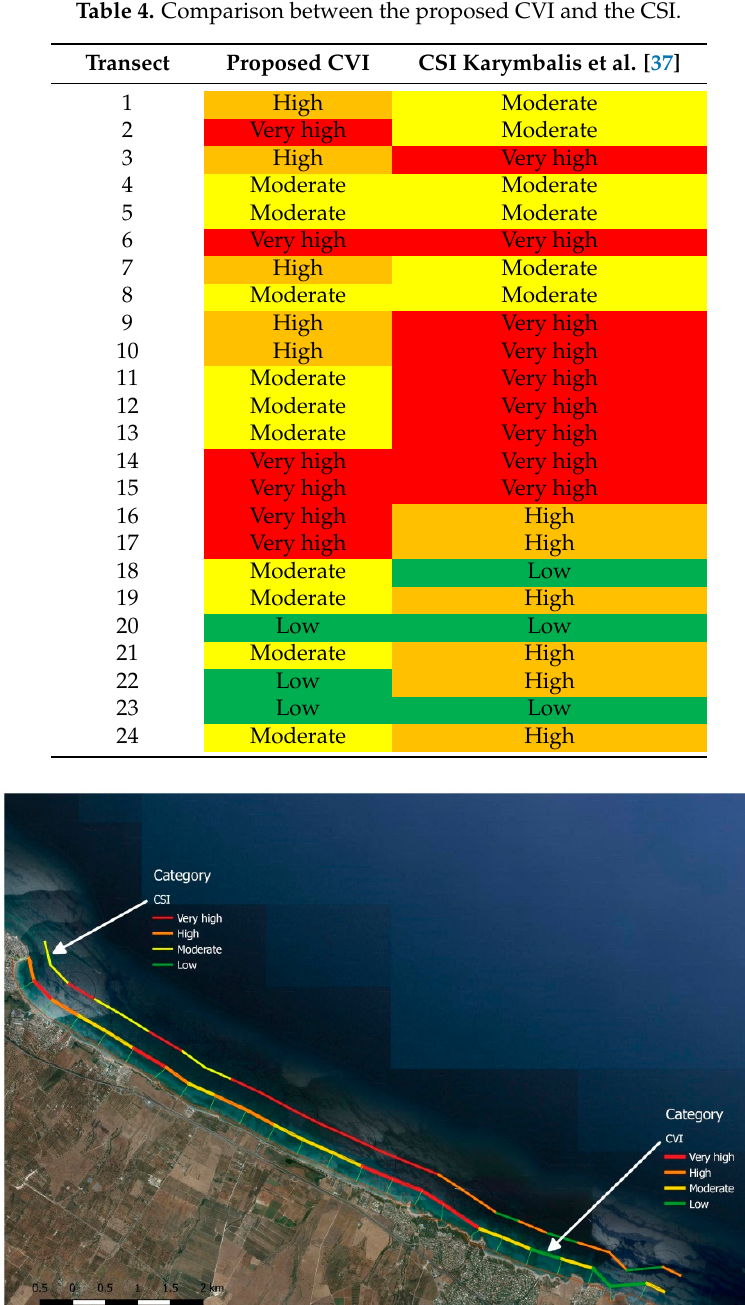
Figure 4. Proposed CVI and CSI values.